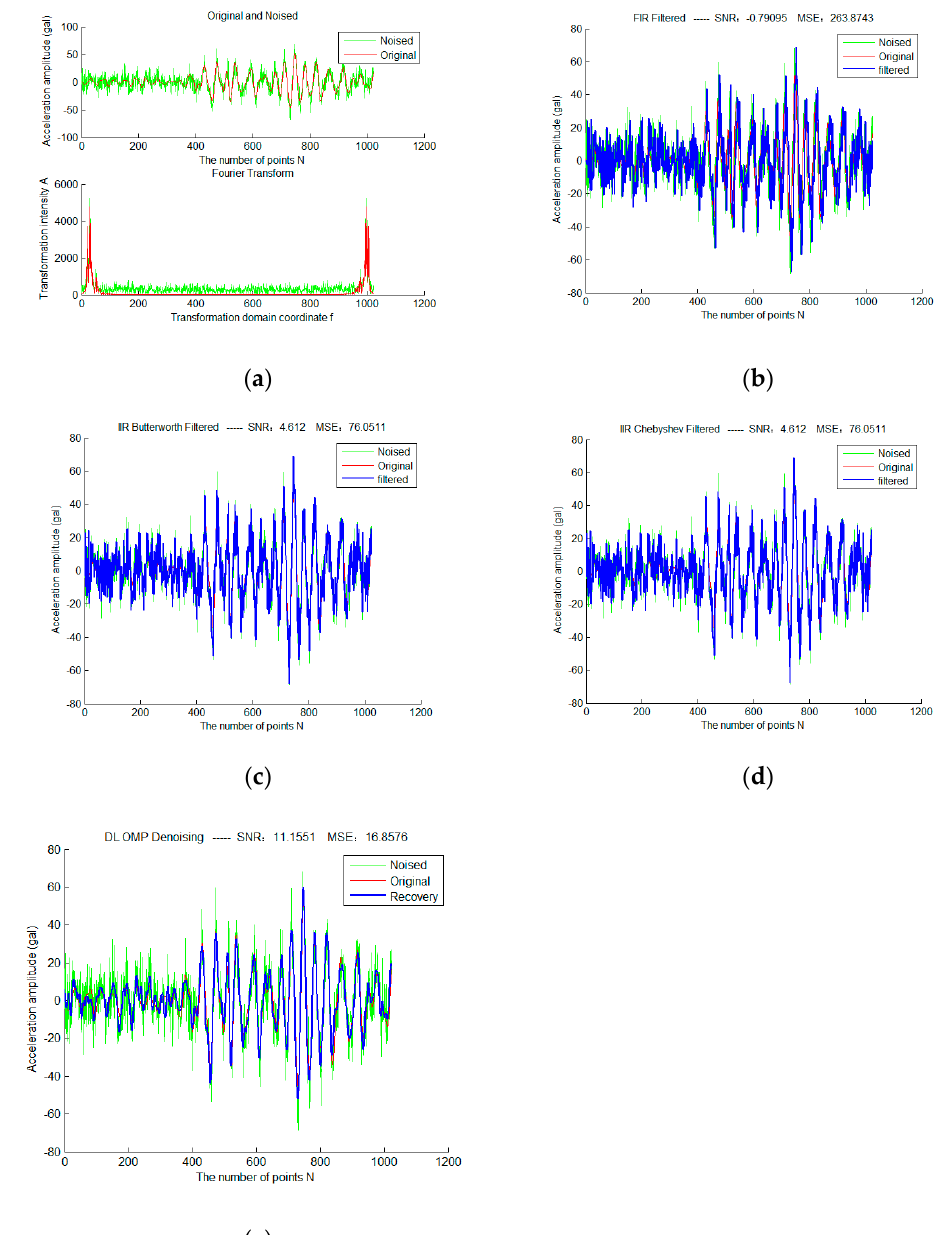
Figure 13. The Spare Denoising Experiment of a Frame of Strong Earthquake Signals Based on the Learning-type Dictionary ( a ) is the original and noise-adding waveforms of the frame signal in the time and frequency domain (sigma = 10); ( b ) is the result based on FIR filtering; ( c ) is the result based on Butterworth filtering; ( d ) is the result based on Chebyshev filtering; ( e ) is the OMP sparse representation denoising result based on the learning-type dictionary.